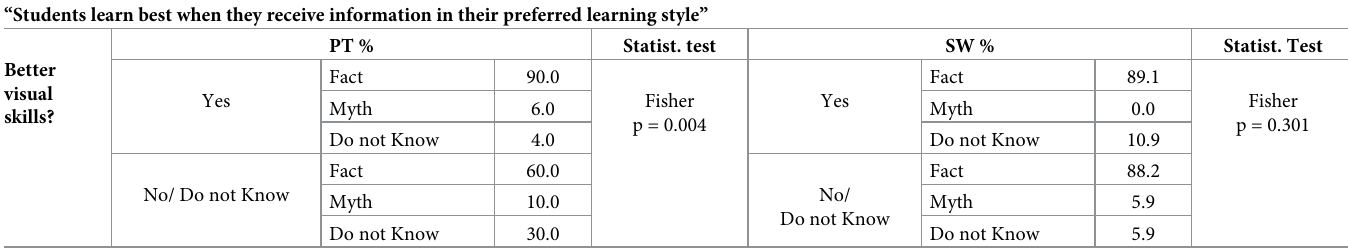
Table 3. Percentage of teachers’ perceptions (DHH visual belief crossed with learning styles neuromyth) (N = 133). “Students learn best when they receive information in their preferred learning